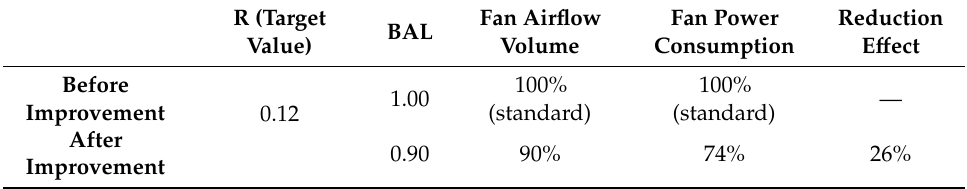
Table 9. Trial calculation of energy-saving e ff ect after improvement of heat-insulation